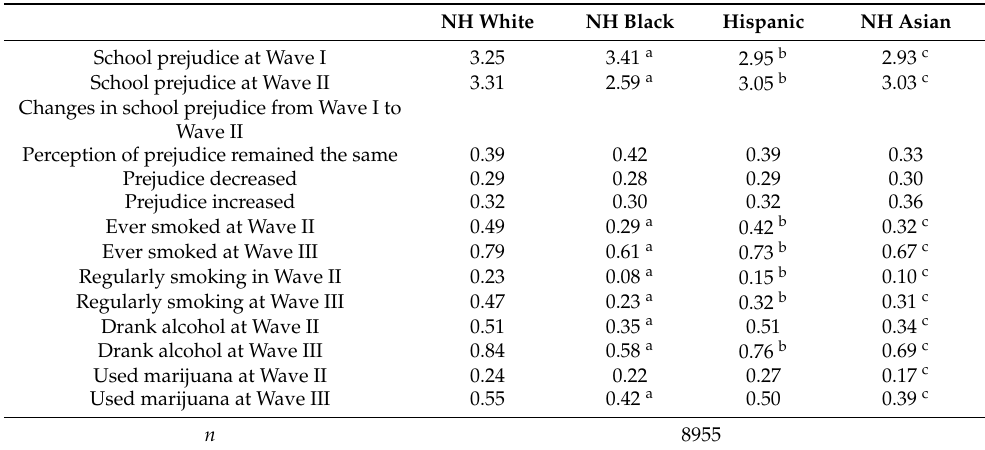
Table 2. Descriptives of the means for the main predictors and outcomes by race and